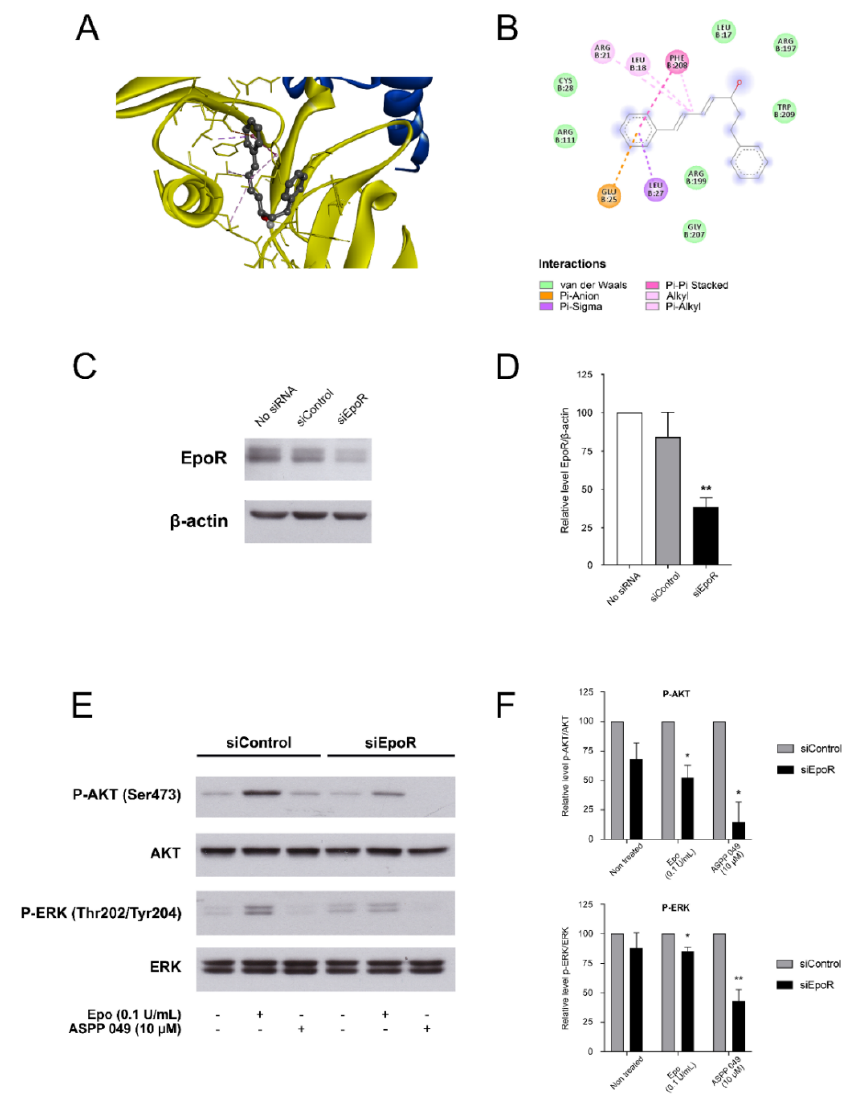
Figure 7. ASPP 049 ‐ mediated Epo ‐ EpoR complex in inducing ERK and AKT phosphorylation. ( A ) Lowest energy position of ASPP 049 within the Epo ‐ EpoR complex, crystal structure represented in gold. ( B ) Two ‐ dimensional interaction profile of ASPP 049 at the binding site of the Epo ‐ EpoR complex. ( C ) Representative blot showing the expression of EpoR in UT7/Epo cells (No SiRNA), or the cells transfected with non ‐ targeting siRNA (siControl) or siEpoR for 24 h. β‐ actin was used as a loading control. ( D ) Graph showing the quantification of EpoR normalized to β‐ actin ( n = 3). ( E ) Representative blot showing the effect of ASPP 049 and Epo on phospho ‐ AKT and phospho ‐ ERK protein expression in the presence of siEpoR. Serum ‐ starved UT7/Epo cells were treated with 0.1 U/mL Epo or 10 μ M ASPP 049 for 30 min and harvested for immunoblotting with anti ‐ EpoR, anti ‐ phospho ‐ AKT (Ser473), and anti ‐ phospho ‐ ERK (Thr202/Try204). All data are representative of three independent experiments. ( F ) Graph showing the quantification of phospho ‐ AKT (Ser473) and phospho ‐ ERK (Thr202/Try204) normalized to total AKT and total ERK, respectively. All data are representative of three independent experiments. * p < 0.05 and ** p < 0.01, ASPP 049 or Epo com ‐